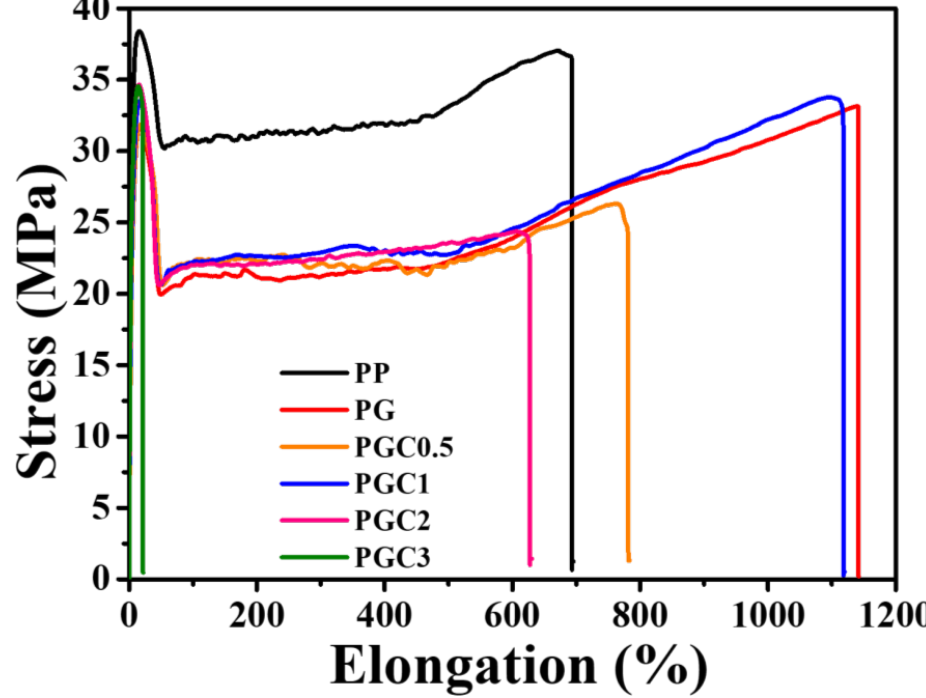
Figure 7. Tensile property of PP and the PP/DCP/GMA/C blends with different tea polyphenols (C) loading. Table 3. Mechanical parameters of PP and the PP/DCP/GMA/C blends with different tea polyphenols (C) loading obtained from Figure 7.